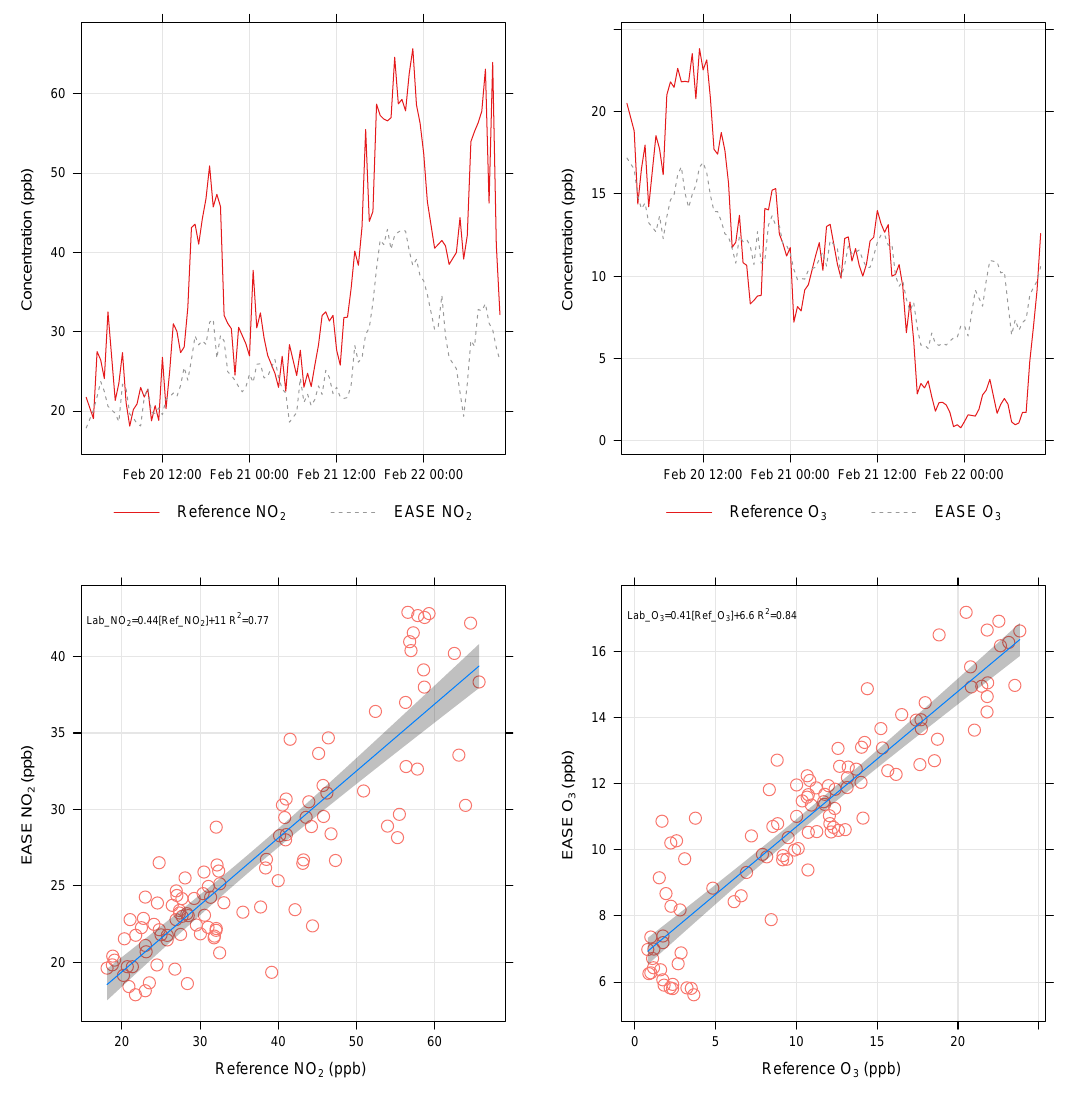
Figure A1. Time-series ( above ) and scatter-plots ( below ) showing the correspondence between the EASE duct and nearby reference station for NO 2 ( left ) and O 3 ( right )